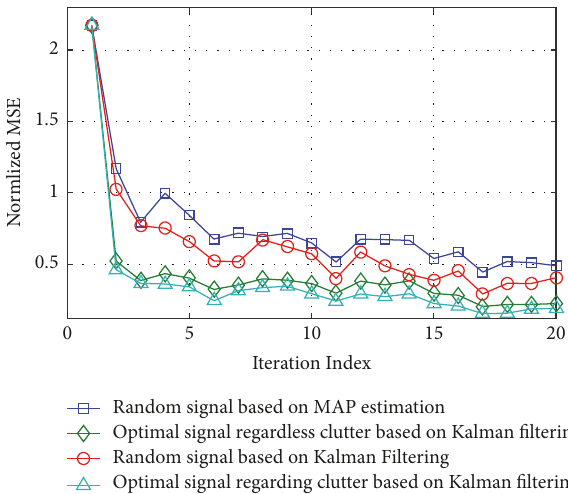
Figure 8: The MSE of TSC estimation under power, SNR, PAPR, and detection